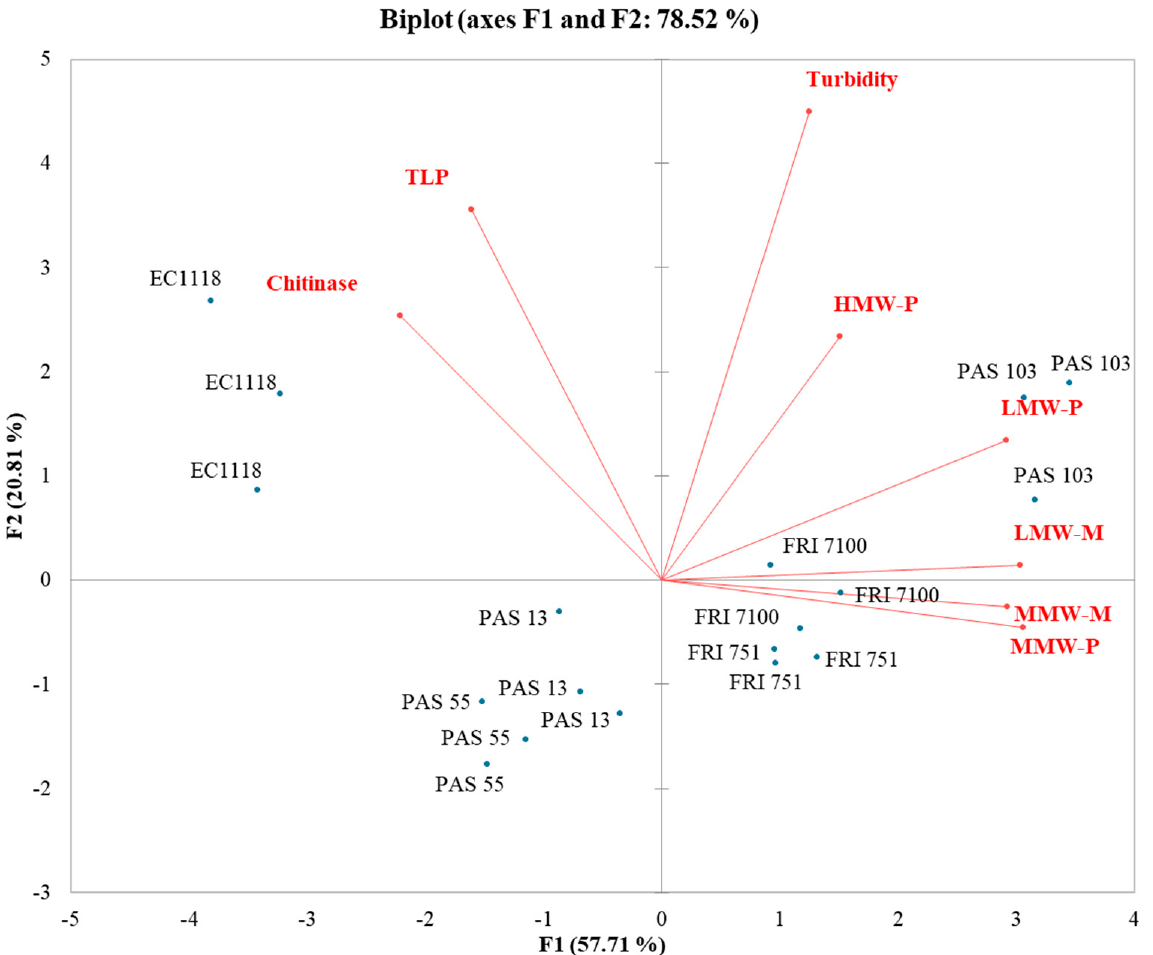
Figure 4. Principal component analysis (PCA) biplot of turbidity, grape proteins, polysaccharides, and mannoproteins in Pinot grigio wines.